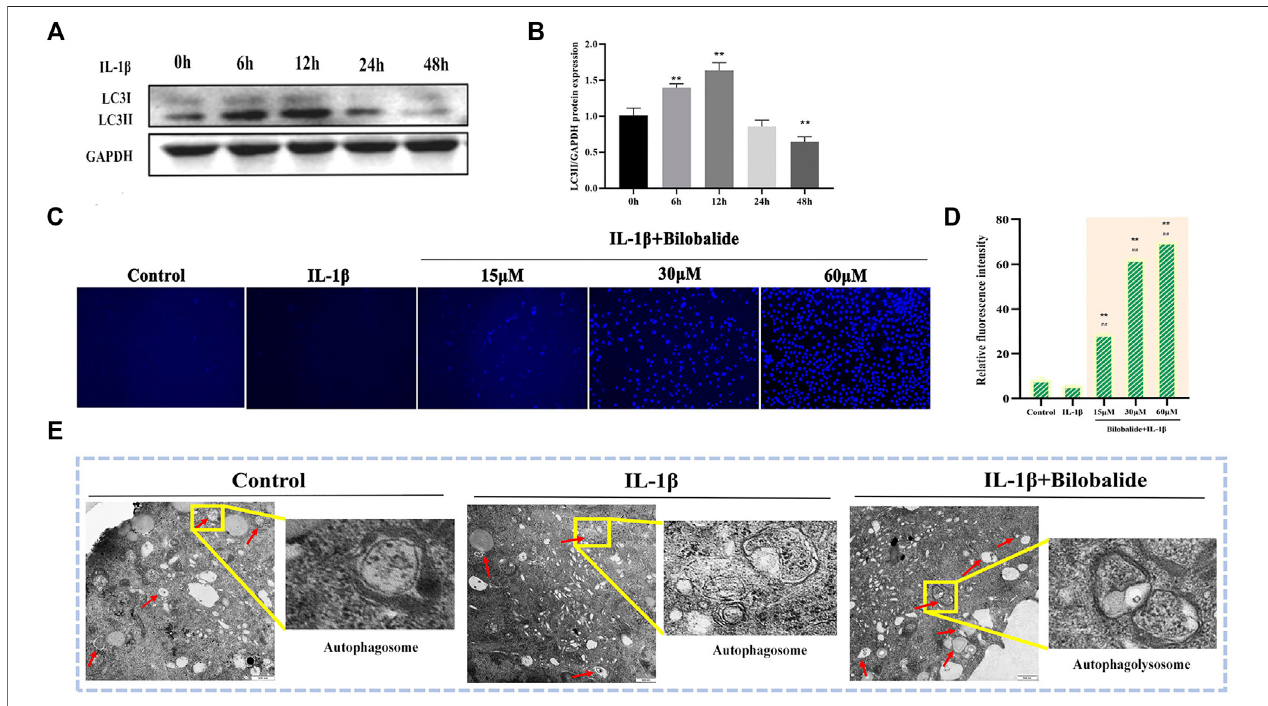
FIGURE 3 | Bilobalide induces autophagy in IL-1 β -induced ATDC5 chondrocytes. (A,B) Western blot analysis of LC3II protein expression after IL-1 β induced cartilage for different periods. (C,D) The number of autophagosomes was observed using MDC dye under a fl uorescence microscope. Magni fi cation ×10. (E) Autophagic vesicles were observed using transmission electron microscopy. Magni fi cation ×3000. All data were presented as mean ± SD ( n = 3). ** p < 0.01 compared to the control group; # p < 0.05 and ## p < 0.01 compared to the IL-1 β group (Statistical analysis using one-way ANOVA and paired two-tailed Student ’ s